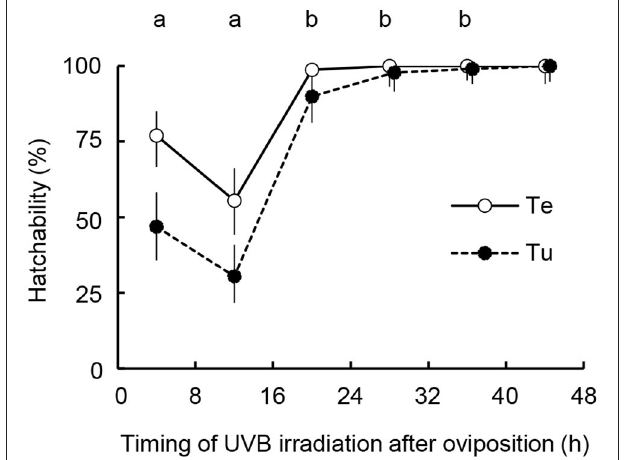
FIGURE 4 | Comparison of age specific vulnerability of N. californicus eggs produced by females fed mites or pollen after irradiation with UVB at 0.192 kJ m − 2 . Prey and food sources of parental females were T. urticae (Tu), peach pollen (Pe), and tea pollen (Te). Each plot shows hatchability calculated from combined data over three replications. Vertical lines on bars show 95% CI. Different letters above the plot area indicate statistically significant differences between the timing of UVB irradiation using the Tukey-Kramer method ( P < 0.05).